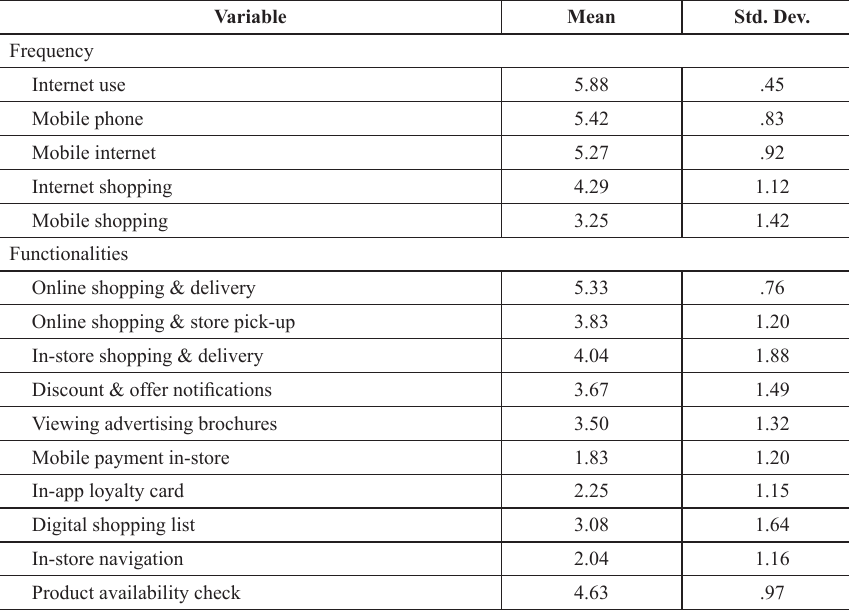
Table 3. Descriptive data of cluster 3 (N=24)